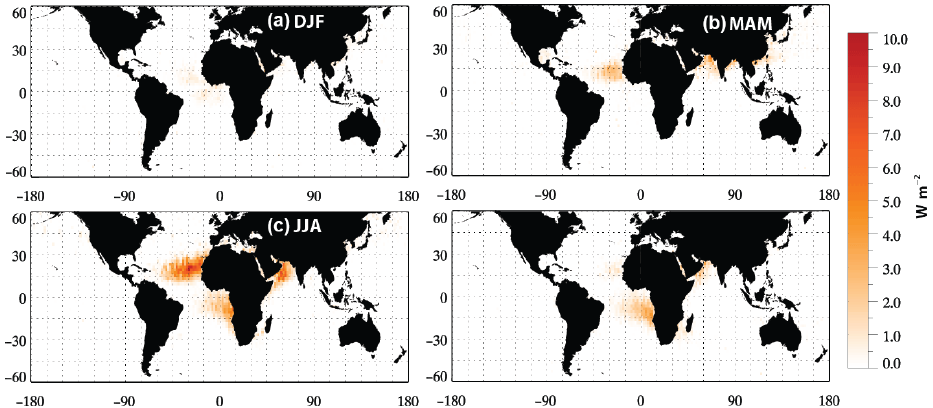
Figure 7. 8-year seasonal mean diurnally averaged shortwave cloudy-sky DRE within the atmosphere, using the CALIOP smoke and OBS dust aerosol models. The ACA AOT in the computation is from the CALIOP operational product without any adjustment.